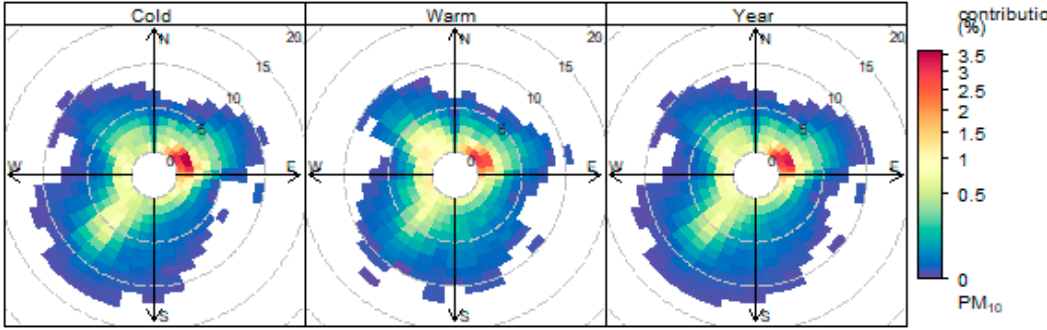
Figure 6. PM 10 weighted concentration rose, the V ěřň ovice site, 2011–2020.